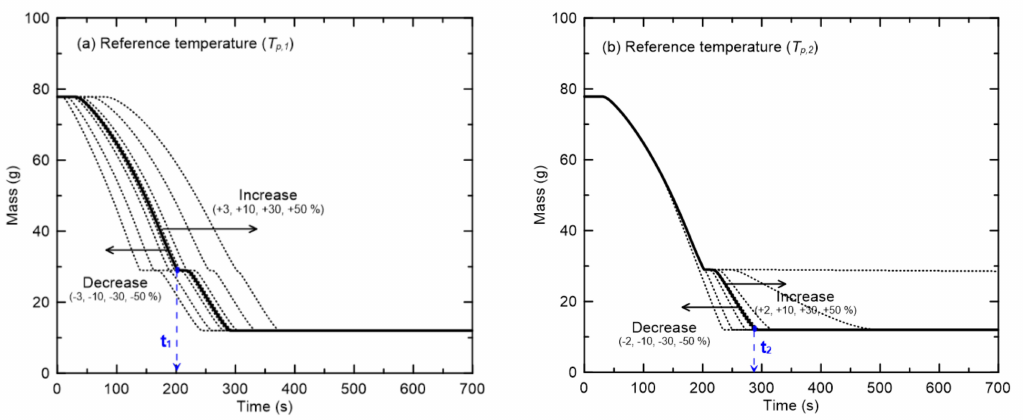
Figure 10. Sensitivity analysis of the reference temperatures in two pyrolysis reactions (( a ) T p ,1 and ( b ) T p ,2 ) on mass